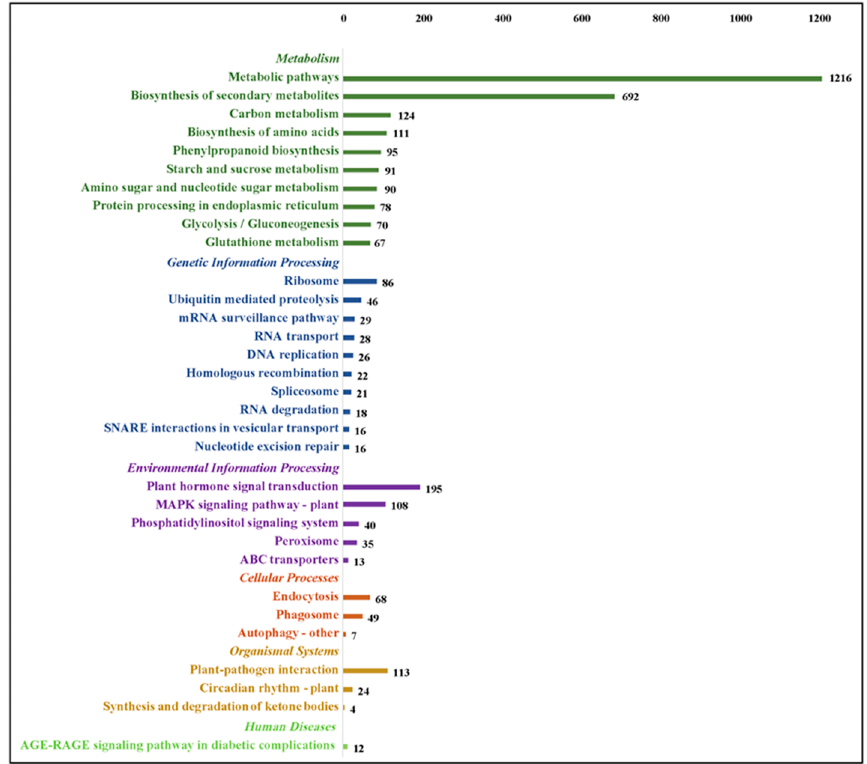
Figure 6. Kyoto Encyclopedia of Genes and Genomes (KEGG) annotation distribution for differen- tially expressed genes in G. anomalum under drought stress. Only top 10 pathway terms are displayed in each group.